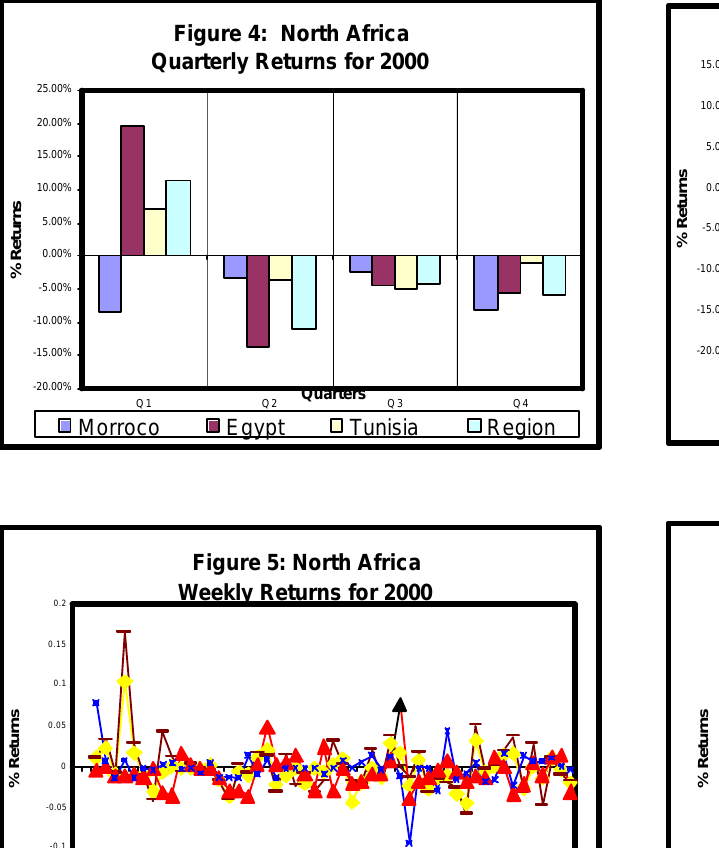
Figure 6: West Africa